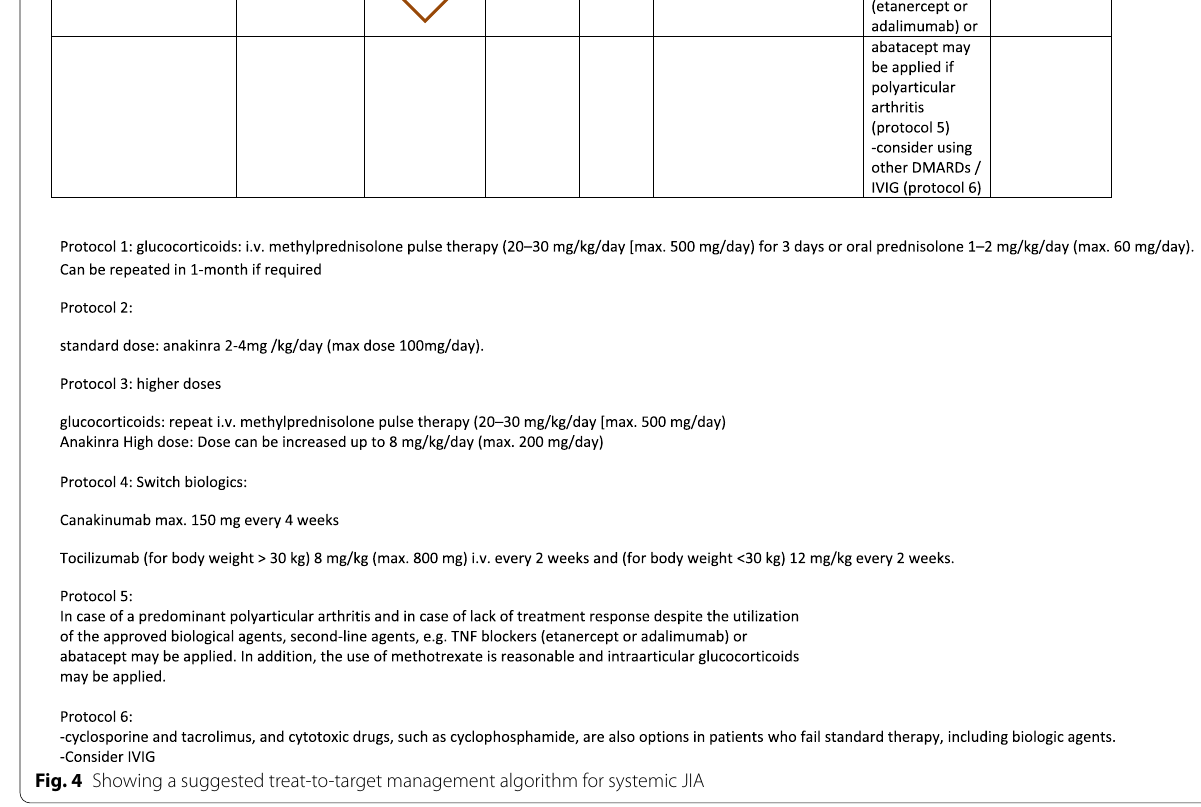
Fig. 4 Showing a suggested treat-to-target management algorithm for systemic